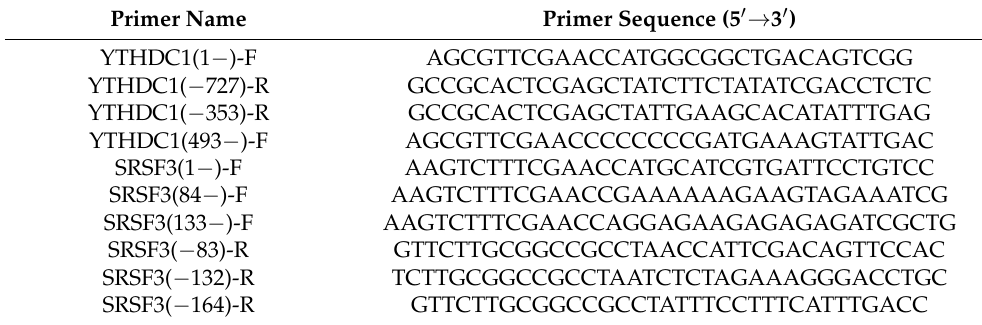
Table 1. Primers used in this